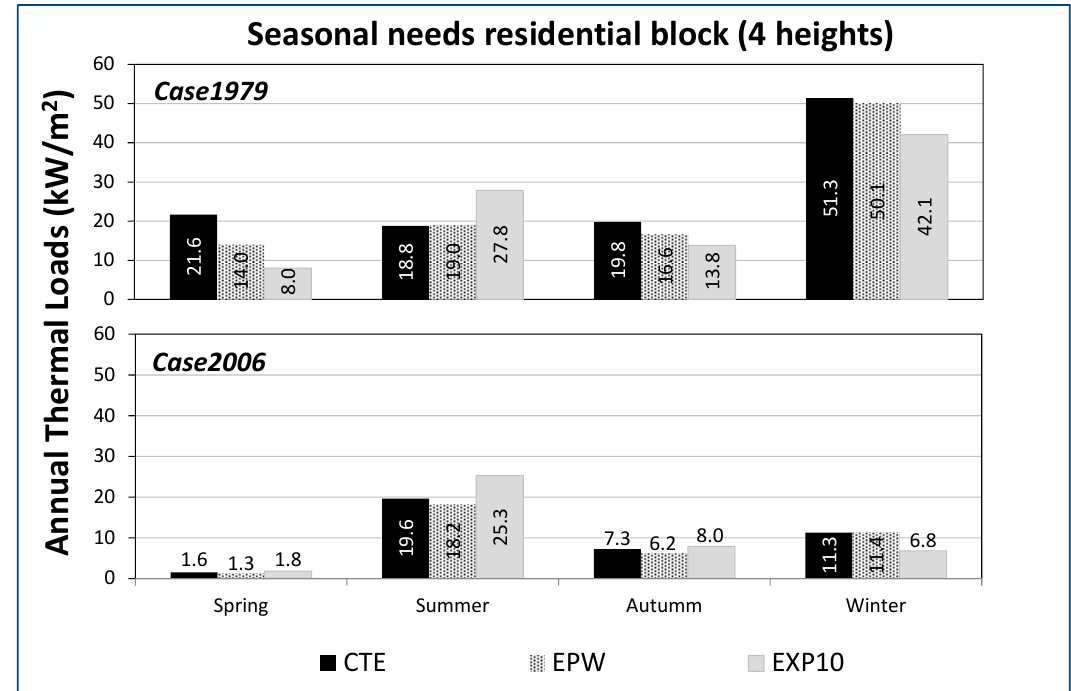
Figure 13. Annual thermal loads obtained with TRNSYS in each season for the three databases studied in Madrid.